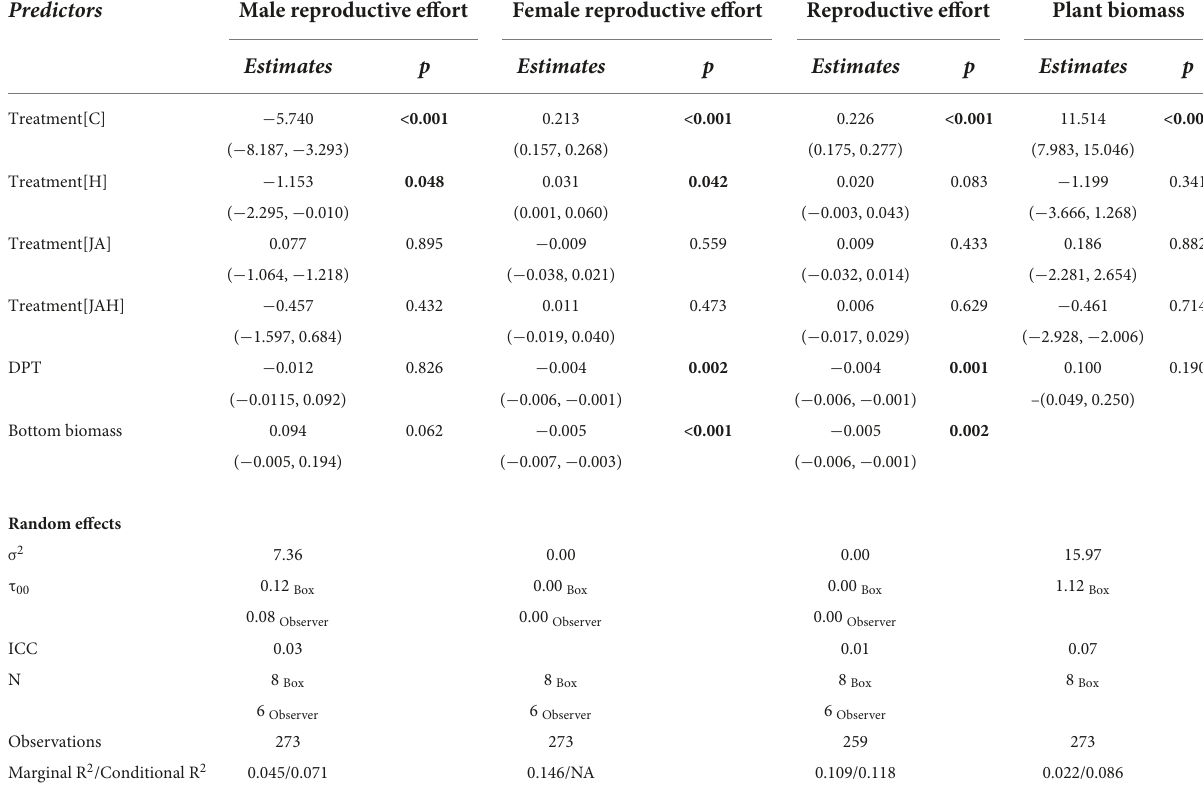
Predictors Male reproductive